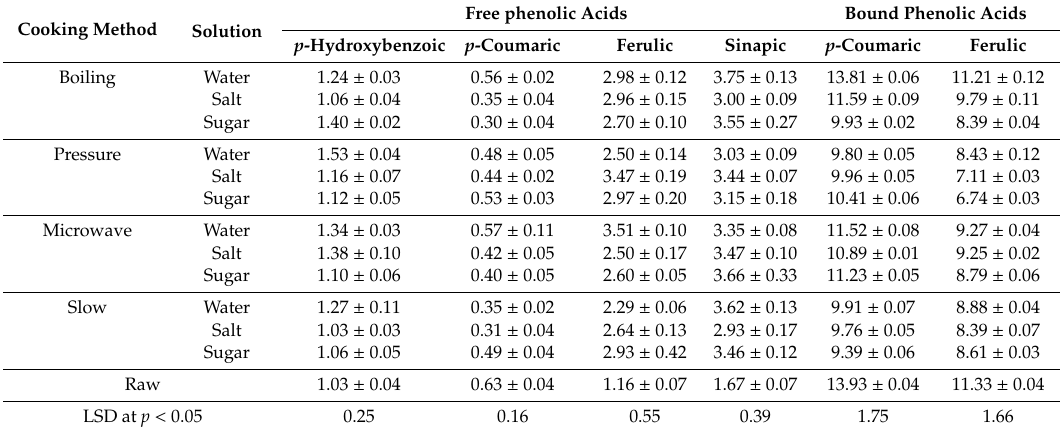
Table 1. E ff ect of four cooking methods on the composition of phenolic acids in faba beans ( µ g / g, db). Cooking Method